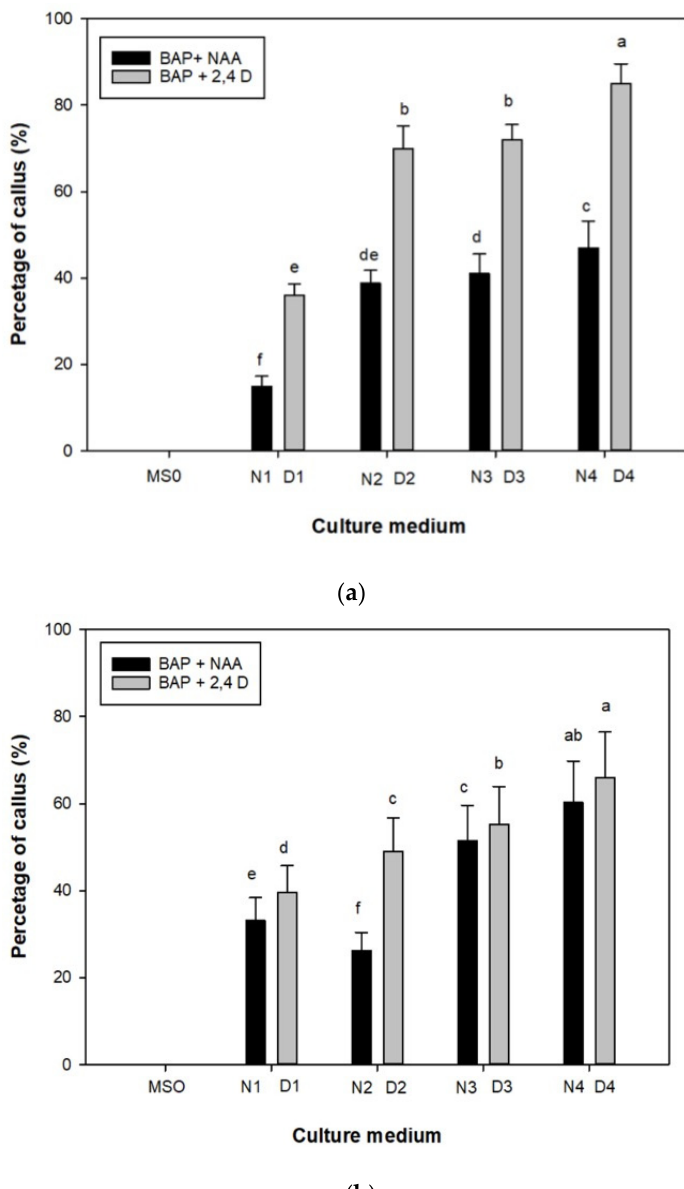
Figure 1. ( a ) E ff ect of di ff erent plant growth regulator (PGR) concentrations on the percentage of callus induction (%) in Adenostyles alpina subsp. macrocephala placed in the dark for one week (n = 40). Bars represent standard error. The di ff erent le tt ers reported above the bars indicate statistically signi fi cant di ff erences between each culture medium tested (Tukey’s test, p ≤ 0.05). MS0 (control, hormone-free, medium with sucrose); N1 (medium with 0.5 mg L − 1 BAP + 1 mg L − 1 NAA); N2 (1 BAP + 1 NAA); N3 (2 BAP + 1 NAA); N4 (3 BAP + 1 NAA); D1 (medium with 0.5 mg L − 1 BAP + 1 mg L − 1 2,4-D); D2 (1 BAP + 1 2,4-D); D3 (2 BAP + 1 2,4-D); D4 (3 BAP + 1 2,4-D). ( b ) E ff ect of di ff erent plant growth regulator (PGR) concentrations on the percentage of callus (%) in Adenostyles alpina subsp. macrocephala placed directly in the light (n = 40). Bars represent standard error. The di ff erent le tt ers reported above the bars indicate statistically signi fi cant di ff erences between each culture medium tested; (Tukey’s test, p ≤ 0.05). MS0 (control, hormone-free, medium with sucrose); N1 (medium with 0.5 mg L − 1 BAP + 1 mg L − 1 NAA); N2 (1 BAP + 1 NAA); N3 (2 BAP + 1 NAA); N4 (3 BAP + 1 NAA); D1 (medium with 0.5 mg L − 1 BAP + 1 mg L − 1 2,4-D); D2 (1 BAP + 1 2,4-D); D3 (2 BAP + 1 2,4-D); D4 (3 BAP + 1 2,4-D).